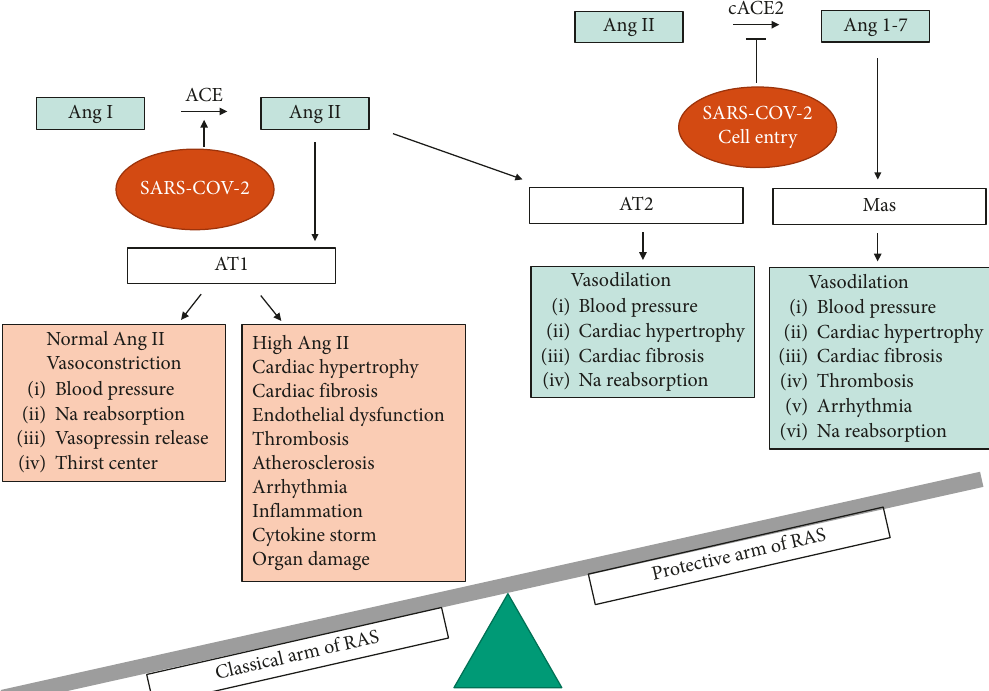
Figure 1: The imbalance in two arms of the renin-angiotensin system in COVID-19 infection: the classical arm vs. the protective